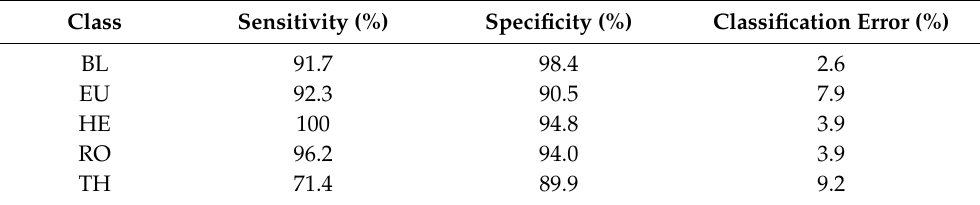
Table 3. Cross-validated multiclass predictions for the set of blossom honey samples using 8 latent variables. BL: Orange/lemon blossom; EU: Eucalyptus; HE: Heather; RO: Rosemary; TH: Thyme. Class Sensitivity (%) Specificity (%) Classification Error (%) BL